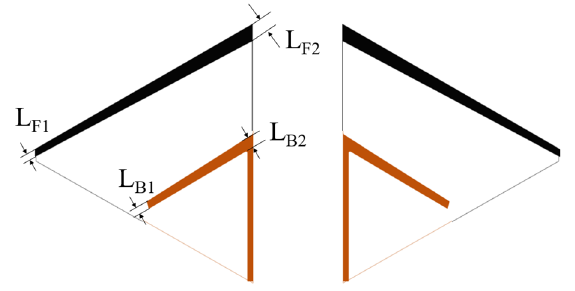
Figure 3. Bionic skeleton parametric design.